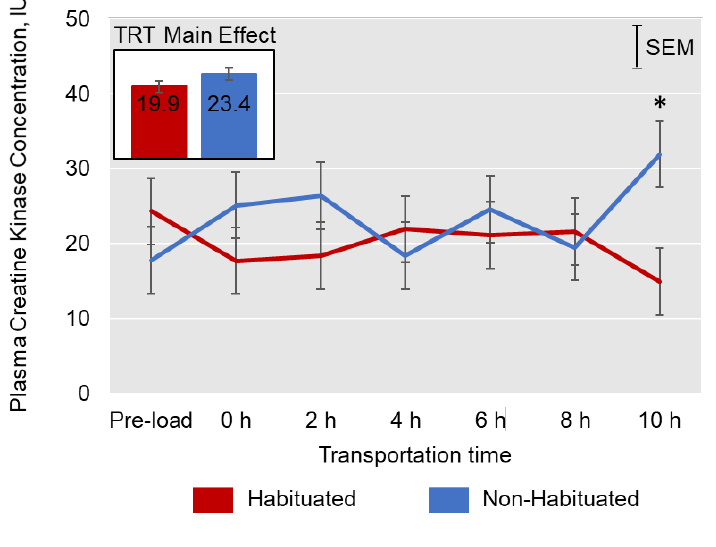
Figure 1. Effects of habituation treatment (TRT) and duration of transportation (Time) on plasma cortisol concentrations in Spanish goats. a–e Time main effect means (average of the two means at each time point) with different letters differ significantly by LSD test at p < 0.05.